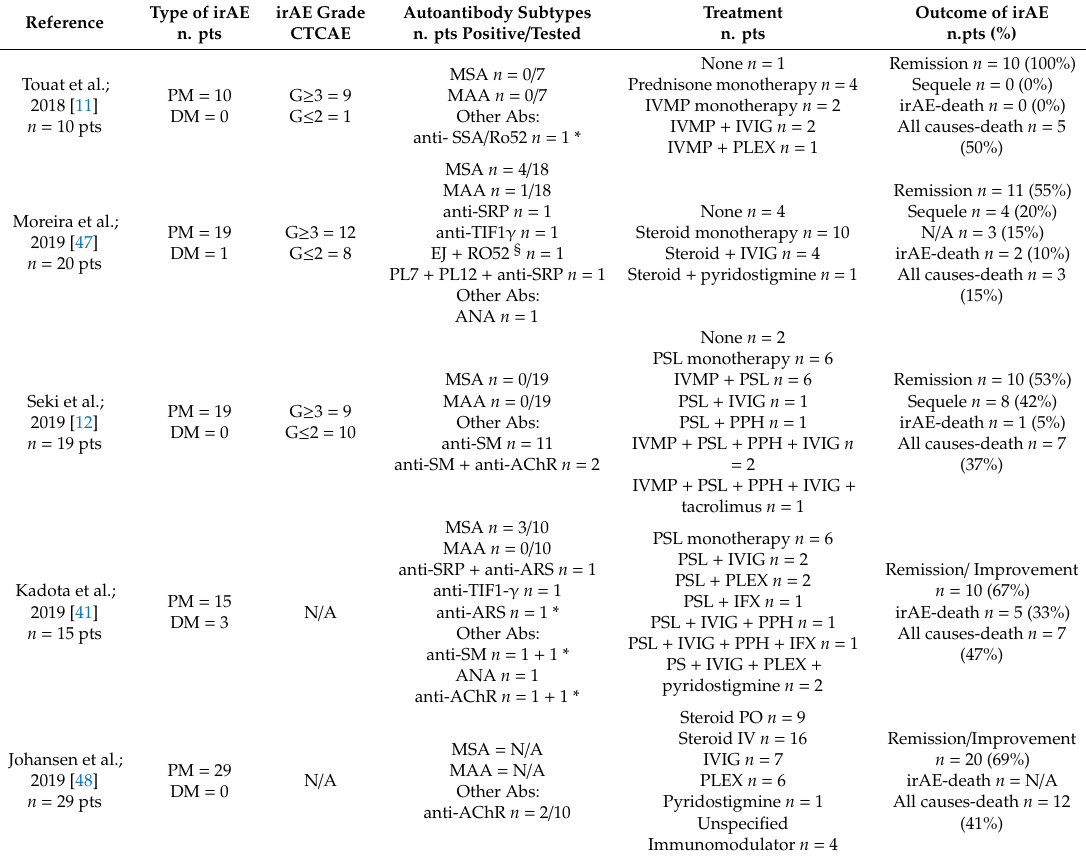
Table 3. Comparison of clinical features, treatment and outcome for ICI-related